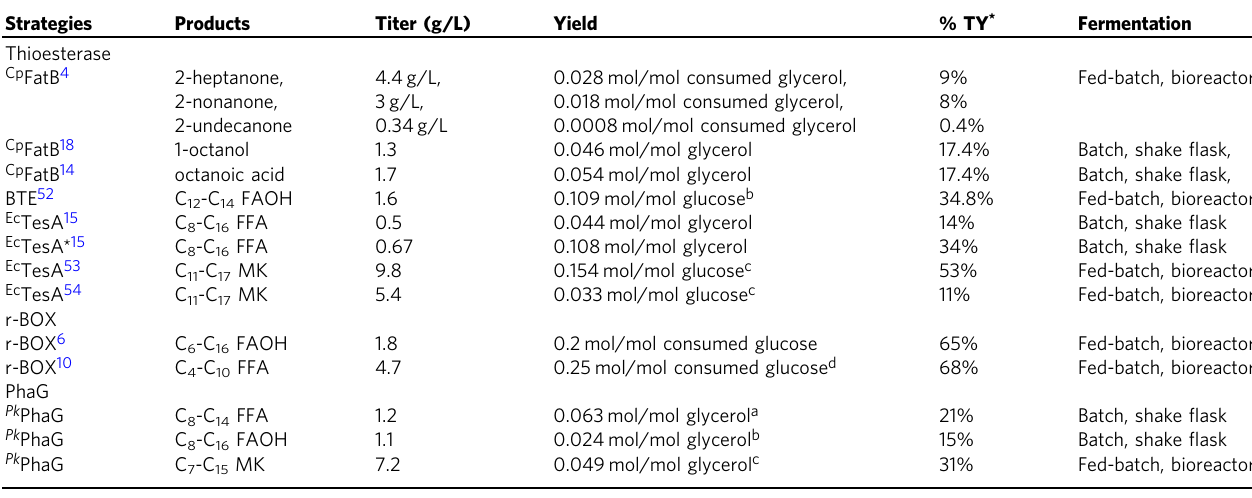
Table 1 Reported titers and yield of oleochemical production using established thioesterase-dependent strategies or developed PhaG-dependent strategies in this work.